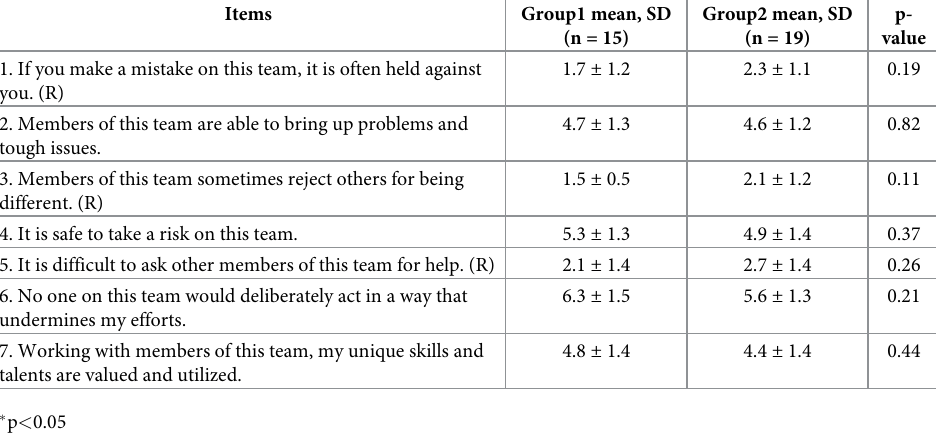
Table 4. Edmondson’s Psychological Safety Scale (intervention).